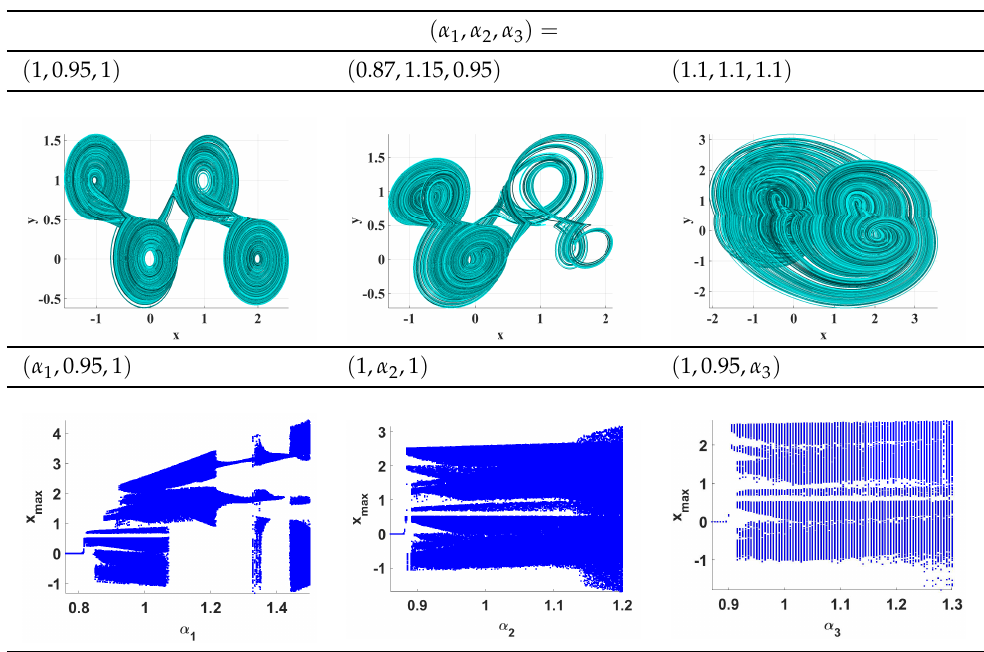
Table 2. x − y projections and bifurcation diagrams of the solution of